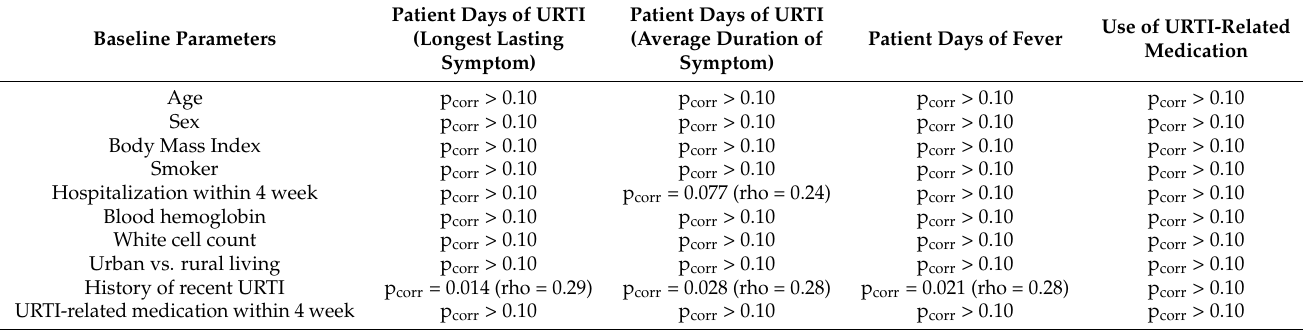
Table A1. Significant correlations (Spearman test) between baseline characteristics and study outcomes. Baseline